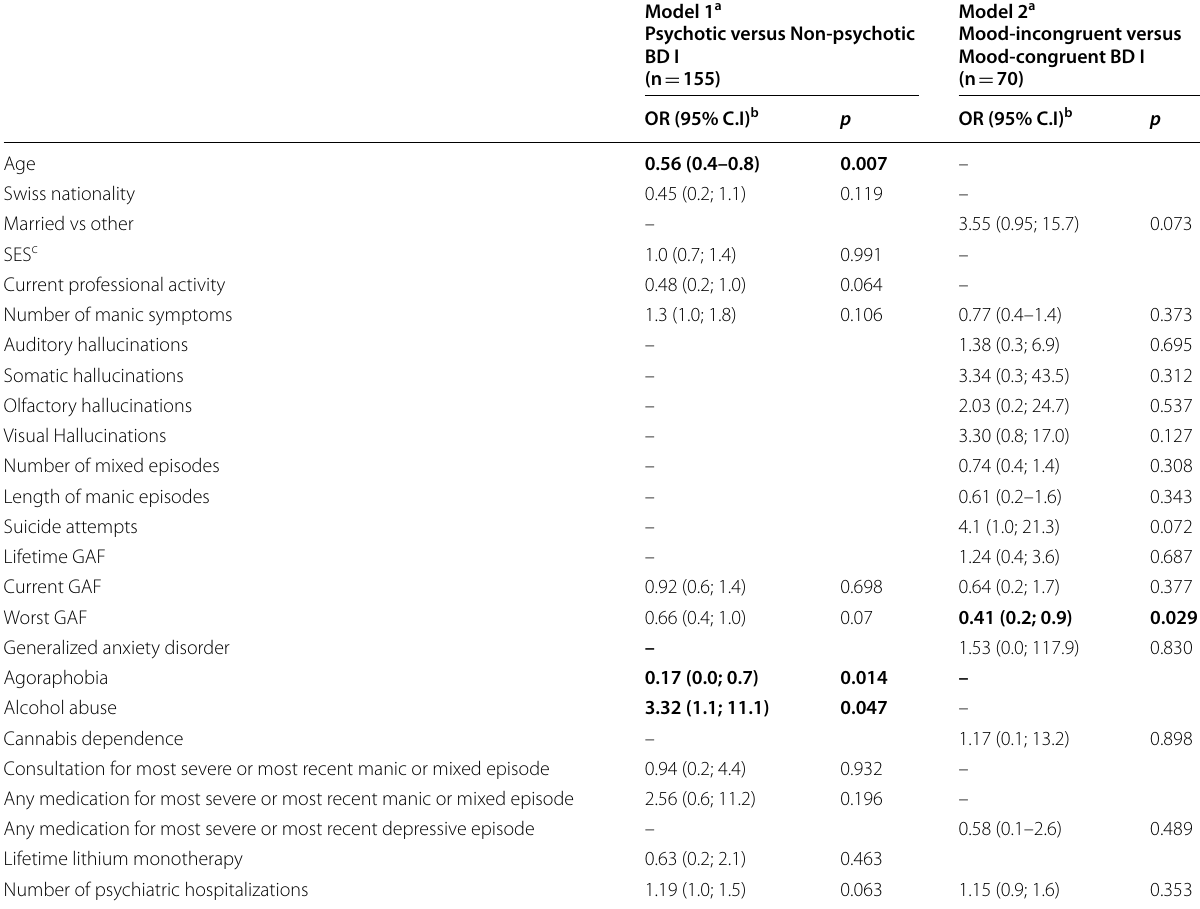
Table 5 Associations of demographic, clinical and treatment characteristics with lifetime psychotic feature status according to two fully adjusted